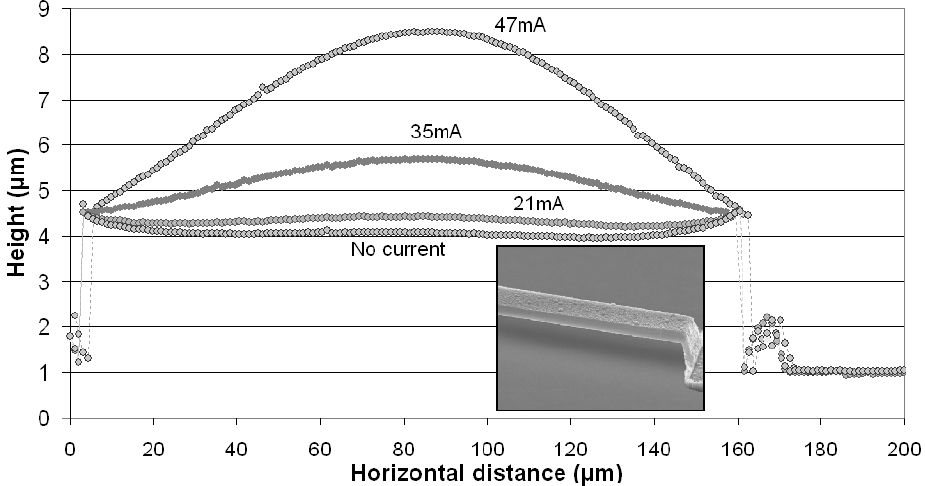
Figure10. Optically measured bending profile of a 150 µm long gas sensor